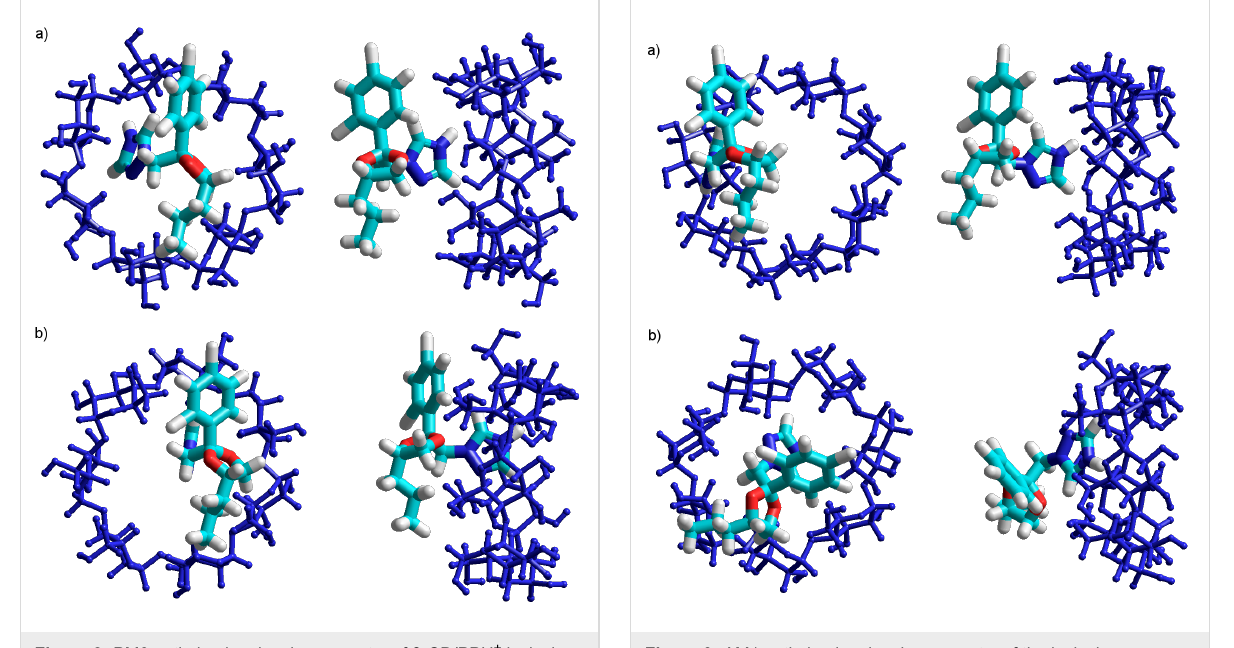
complex has the highest stability in the B configuration. The binding energy of the B configuration is 43.28 kJ/mol lower than that in the A configuration (Table 3). The significant difference between stabilization energies leads to a rather big difference between molecular structures. Thus, while in the more stable B configuration the PPH + is included with the azole ring in the β -CD cavity, at the level of the wider rim (Figure 9a), in the A configuration, the PPH + molecule is completely outside of the cavity (Figure 9b). Both AM1 and PM3 calculations indicate a strong correlation between the stabilization energy and the electric dipole moments (Table 3).